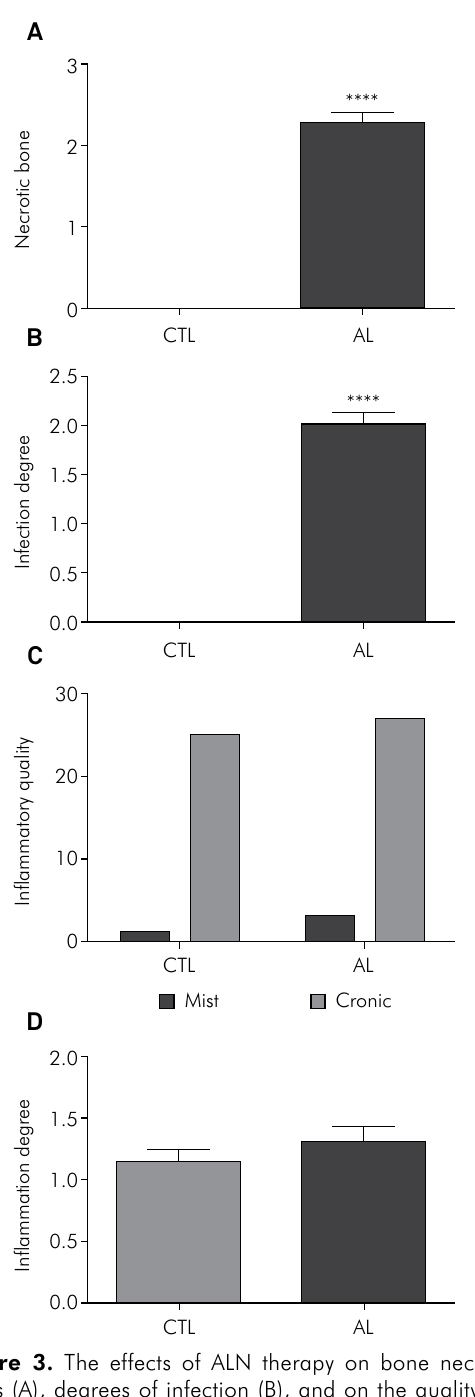
Figure 3. The effects of ALN therapy on bone necrotic levels (A), degrees of infection (B), and on the quality (C) and degree (D) of inflammation at 28 days after tooth extraction. (A) Animals treated with ALN developed a higher proportion of bone necrosis compared with matched controls (****p < 0.0001). (b) Animals treated with ALN presented an increased degree of infection compared with matched controls (****p < 0.0001). No differences were found regarding the quality (C) and degree (D) of inflammation between the groups studied.